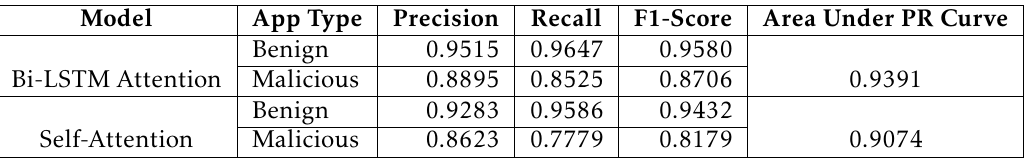
Table 4. Comparison of the two deep learning